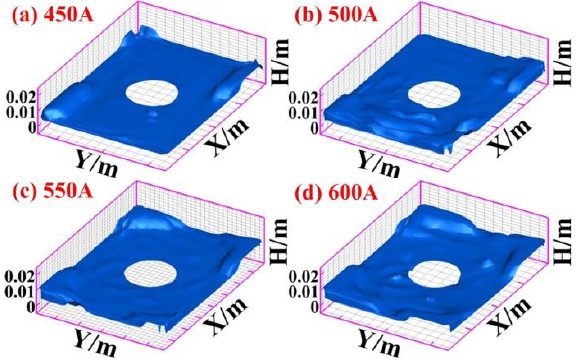
Figure 15. Comparison of three dimensional level fluctuations under different current intensity.